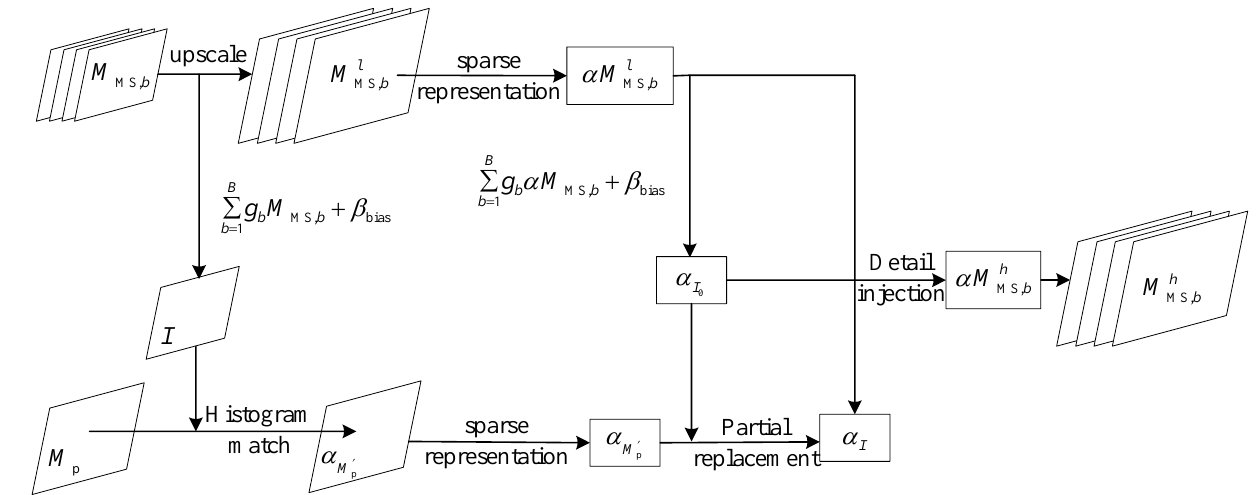
Figure 2. Flow chart of image fusion algorithm based on sparse representation.